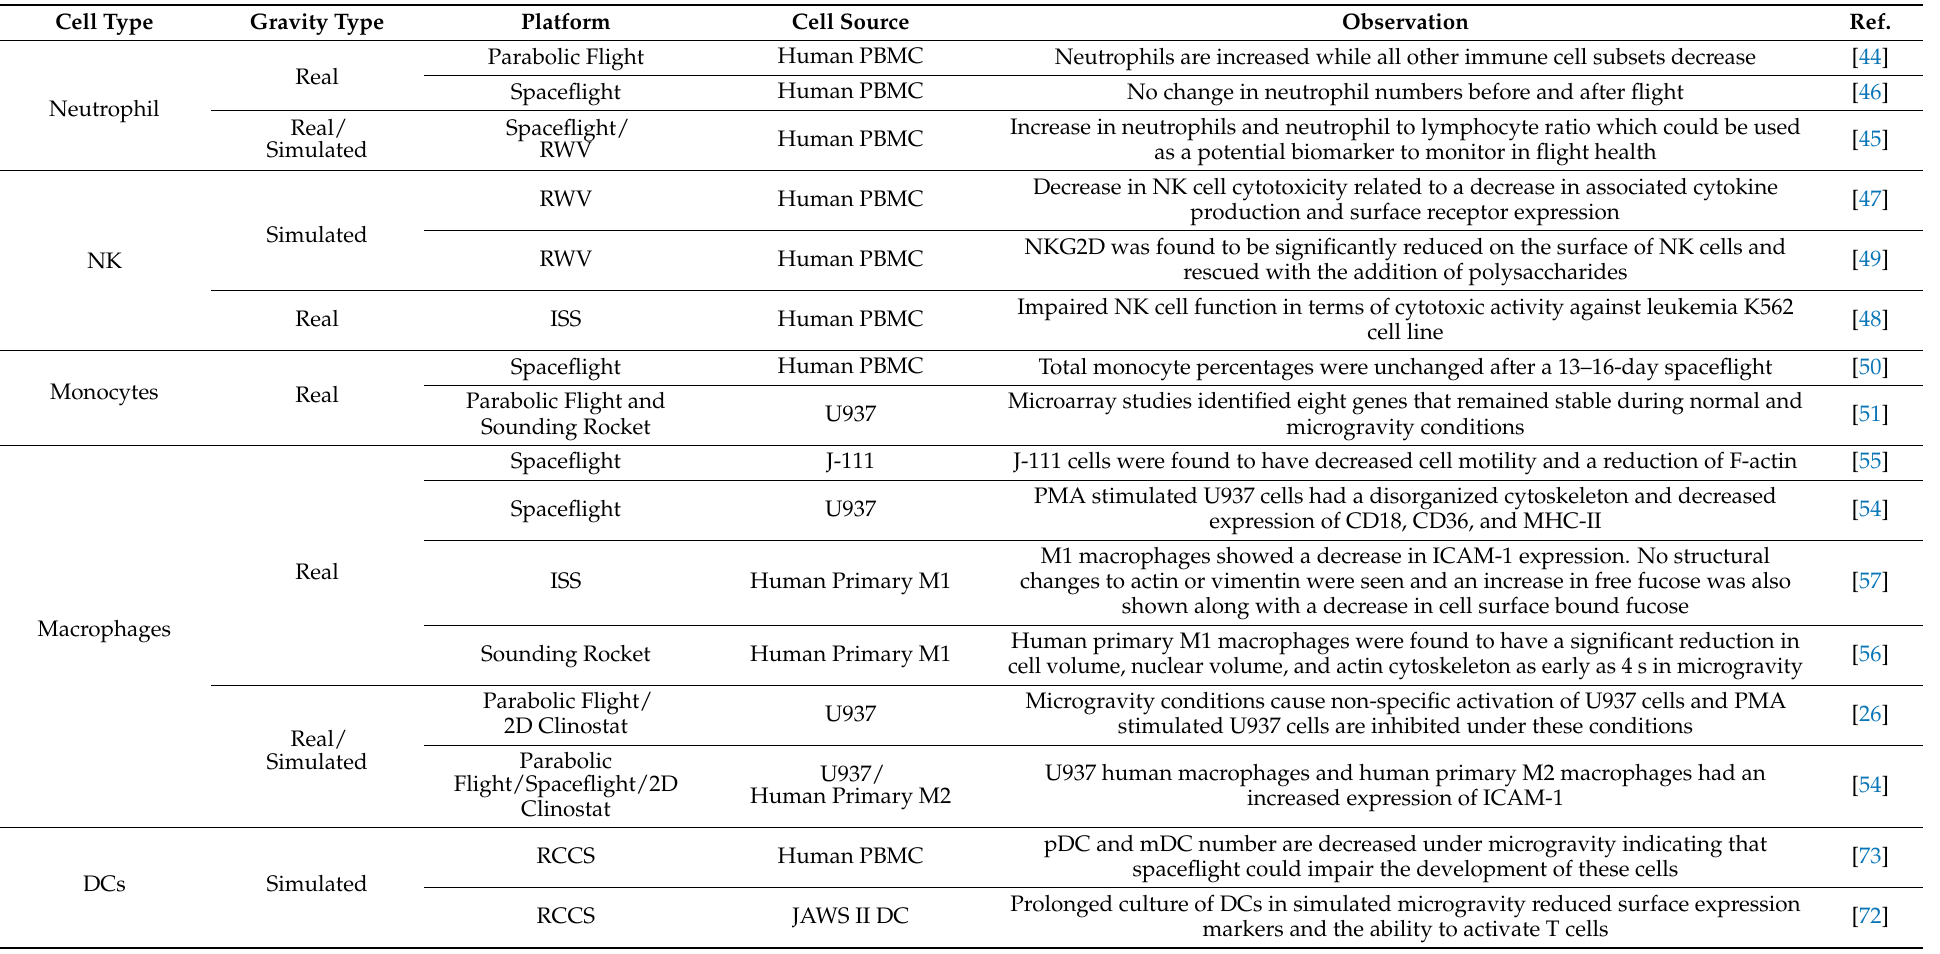
Table 1. Overview of the effects of microgravity on cells of the innate immune